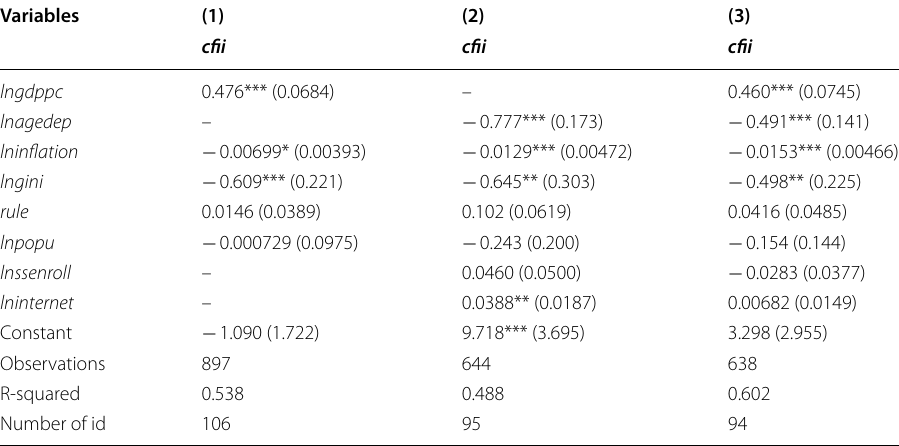
The dependent variable is composite financial inclusion index. For details of the explanatory variables, see Appendix B. All standard errors are robust and reported in parentheses. The symbols ***, **, and * indicate statistical significance at the 1%, 5%, and 10% level,